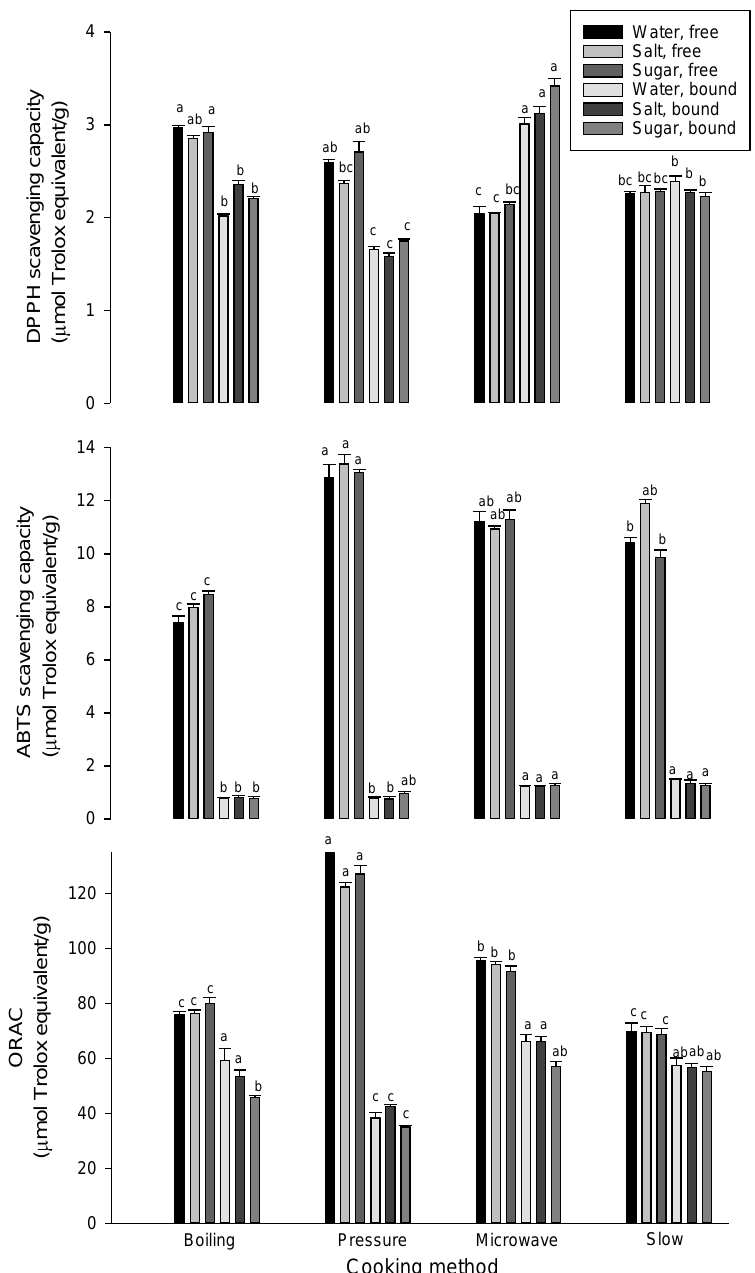
Figure 2. Antioxidant capacities of free and bound phenolic extracts of lentils (µmol trolox equivalent/g, db) measured by DPPH (top), ABTS (middle) and ORAC (bottom) assays. For free or bound phenolic extract, means followed by a different letter are significantly different at p < 0.05. Error bars represent standard deviation values ( n = 3).